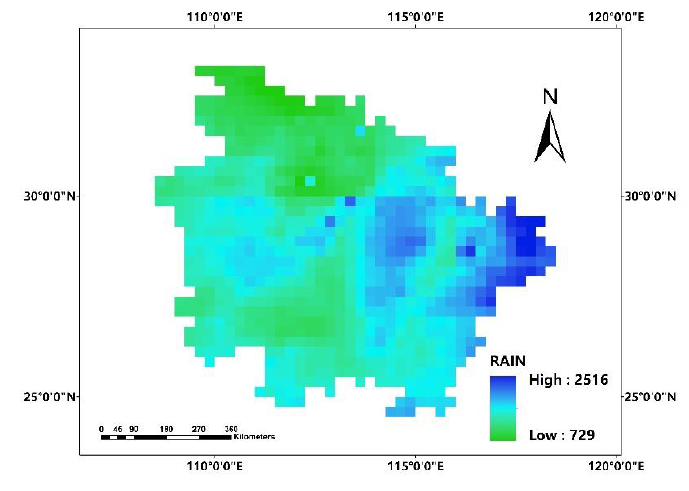
Figure 11. Annual mean rainfall.